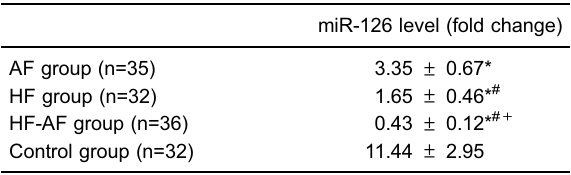
Table 3. Comparisons of serum miR-126 levels among the